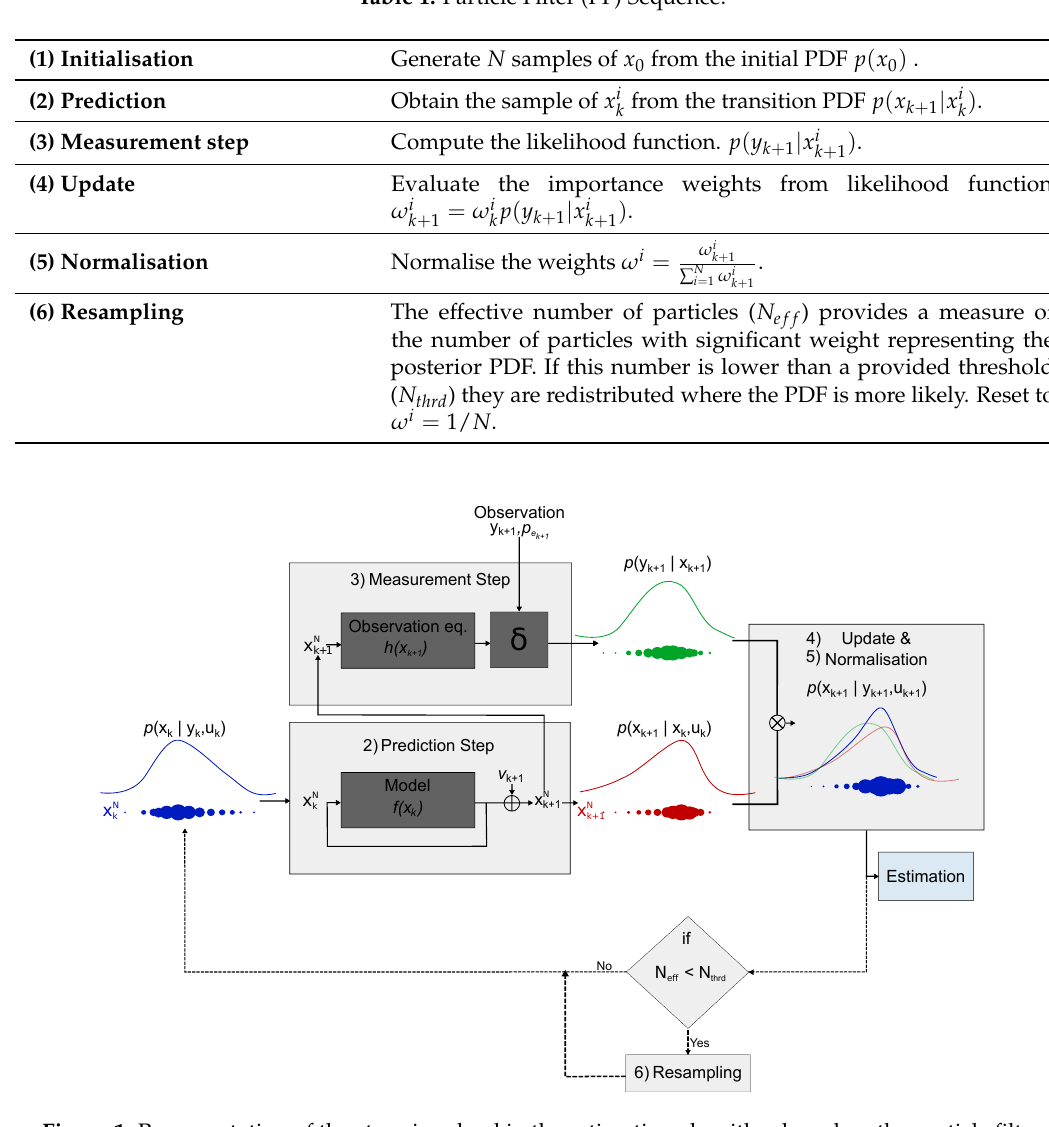
Table 1. Particle Filter (PF) Sequence.